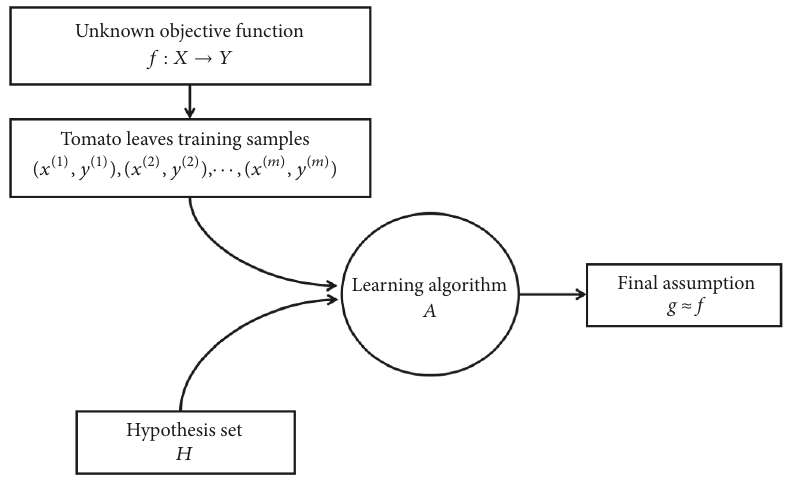
Figure 1: Proposed workflow